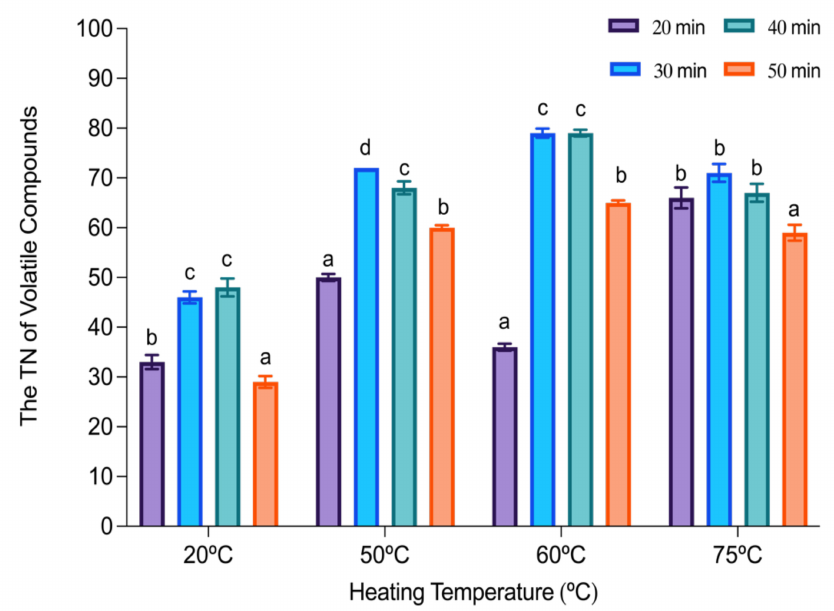
Figure 3. The total number (TN) of volatile compounds regarding heating temperature ( ◦ C) and extraction time (min). Different letters denote statistically significant differences ( p < 0.05) between different times of extraction for each temperature.